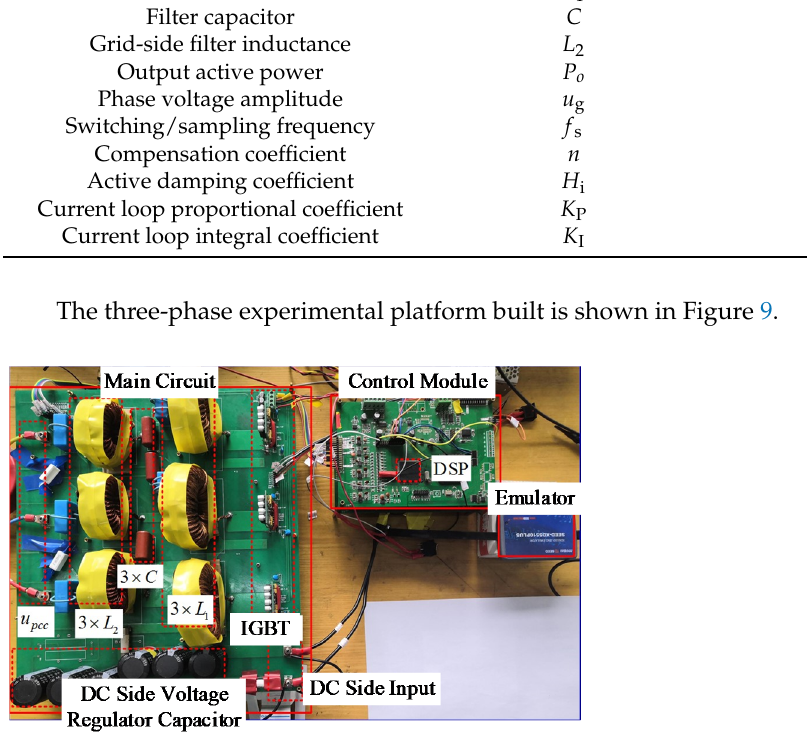
( b ) Figure 12. Experimental results under strong grid: ( a ) switching of delay compensation links; ( b ) network current and PCC voltage at steady state.